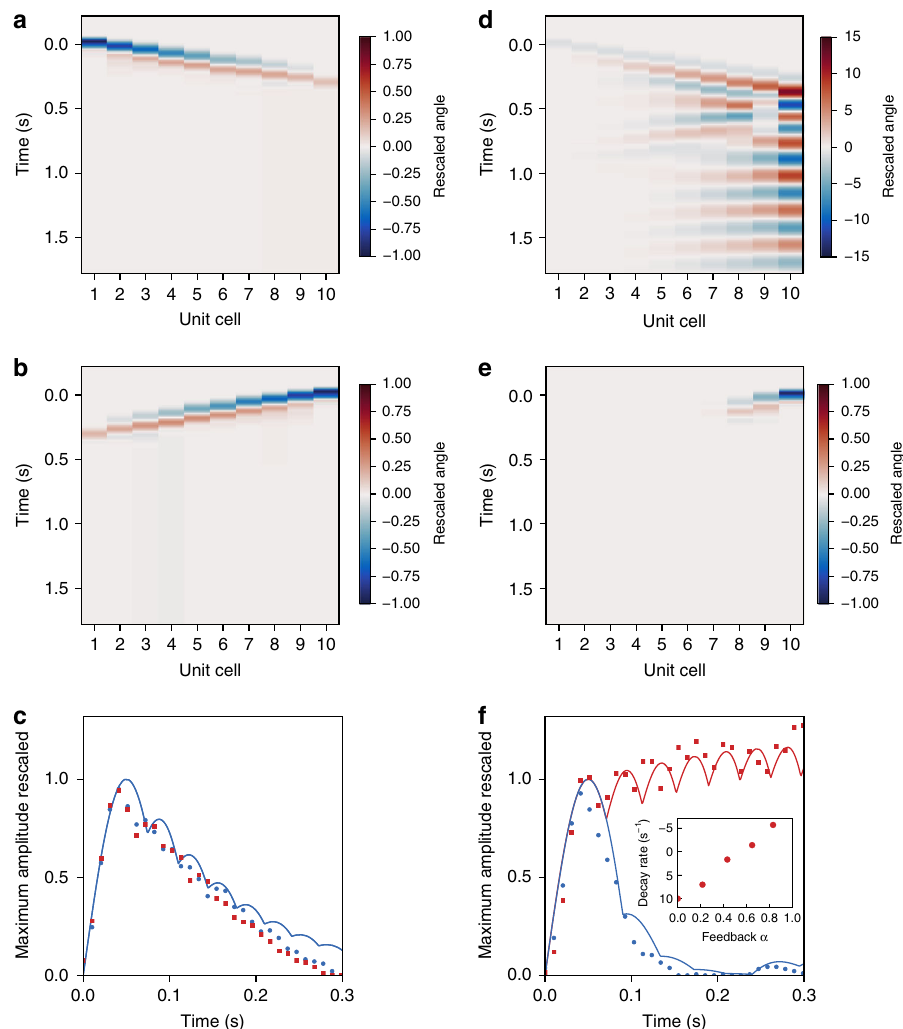
Fig. 4 Unidirectional pulse ampli fi cation. a – e Contour plots of the angular displacement vs. space coordinate and time for a feedback parameter α = 0 (ab) and α = 0.62 (de), upon pulse excitation on the left (ad) and right (be) edge of the metamaterial. (cf) Instantaneous maximum magnitude of the propagation pulse vs. time for a feedback parameter α = 0 (c) and α = 0.62 ( f ). The points correspond to the experimental data, the thin solid lines to the numerical model without any fi t parameters. (f-inset) Decay rate δ derived from exponential fi ts of the form exp( − δ t ) on the maximum amplitude of pulses propagating from left to right for different values of the feedback parameter. See also Supplementary Video